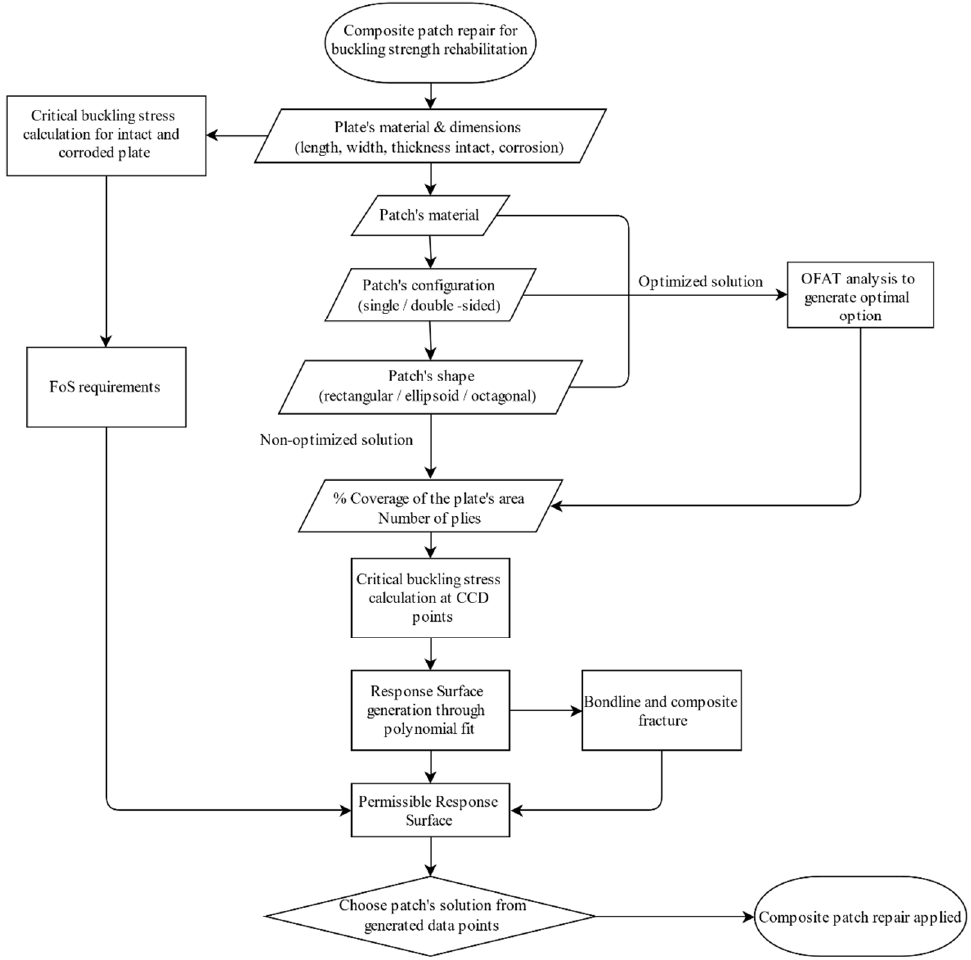
Figure 6. Flowchart of the proposed preliminary design methodology.